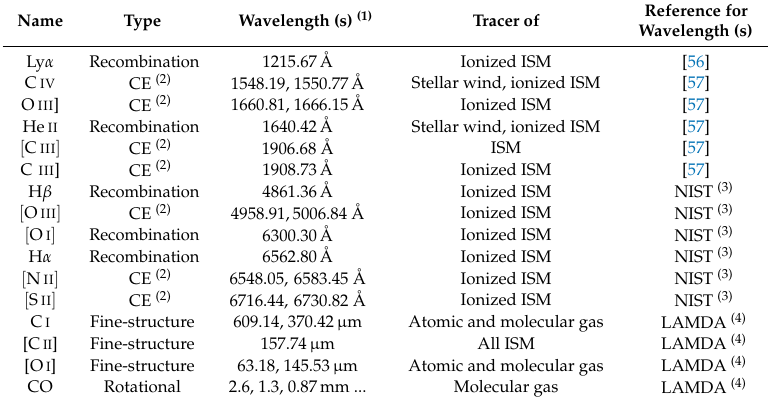
Table 1. Overview of the lines discussed at the workshop and referred to in the remainder of this